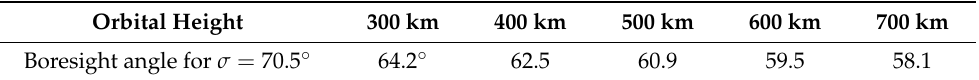
Figure 5. Schematic representation of NASA-JPL MISR view angles, all within the view-angle range reached by HORUS (not to scale).